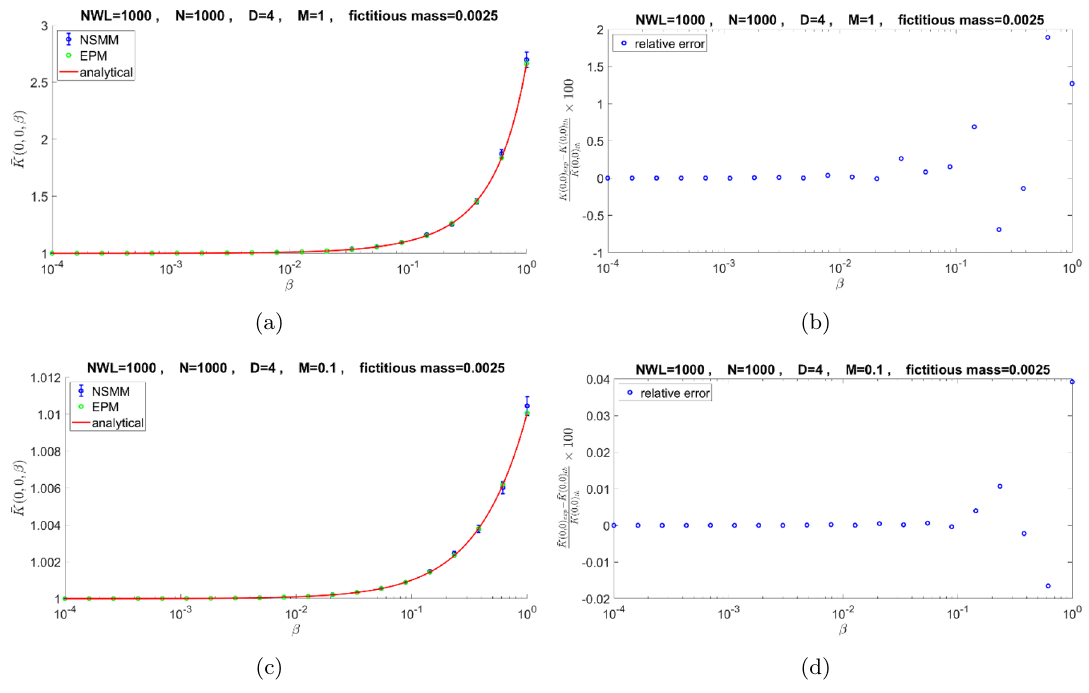
Figure 5 . Calculations of the heat kernel for the free scalar particle on the sphere with M = 1 (top) and M = 0 . 1 (bottom). The relative errors between the blue and the green data have been shown in the figures on the right. All other parameters are kept